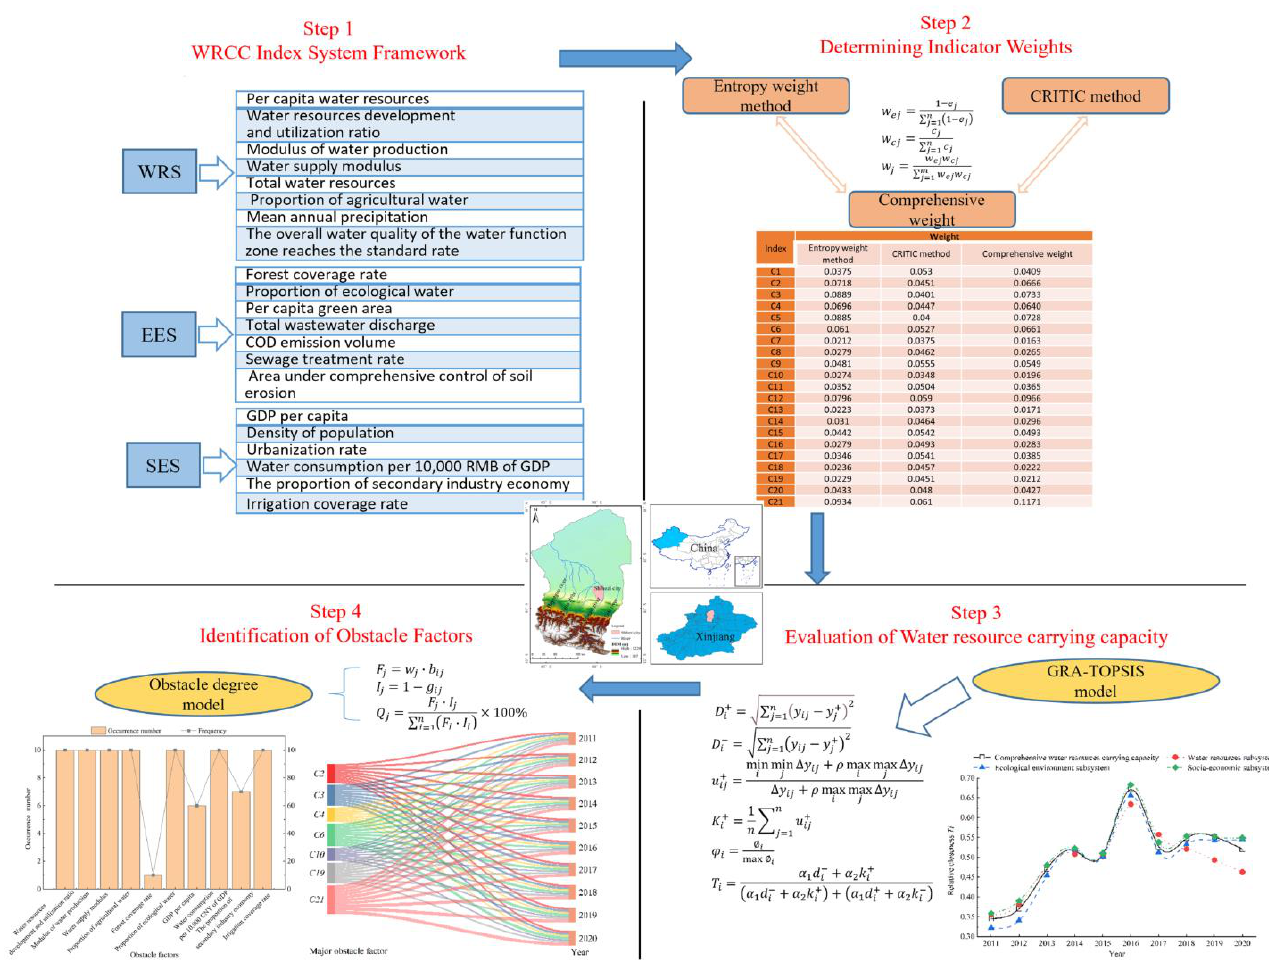
Figure 1. General framework of this paper.